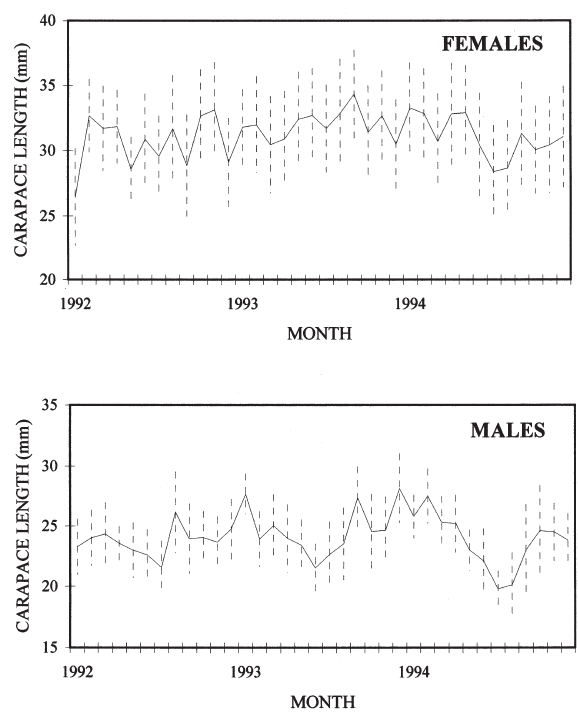
F IG . 3. – Monthly variation of the mean sizes and standard deviation for males and females of Aristeus antennatus from landings in the port of Santa Pola during 1992, 1993 and 1994.